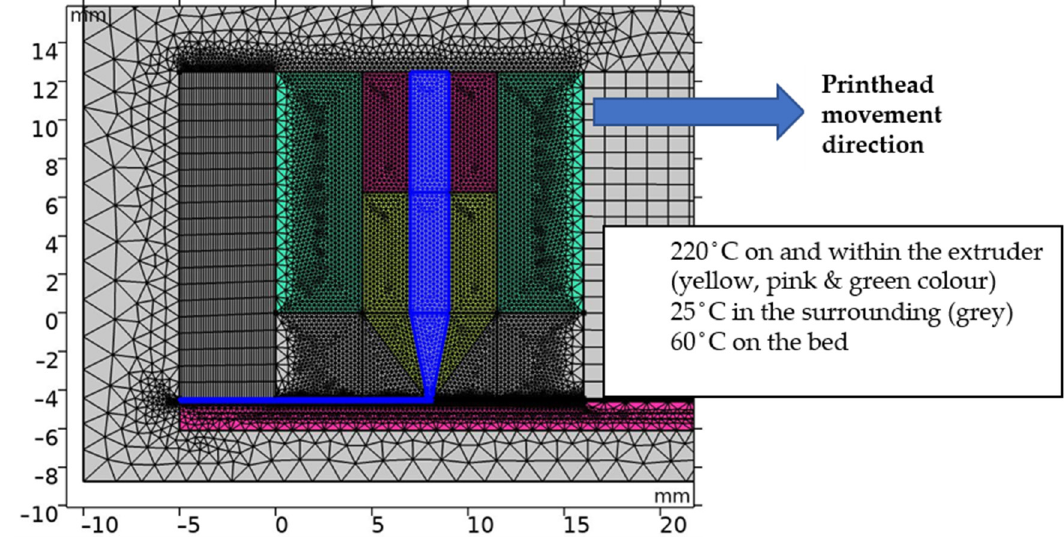
Figure 2. Geometry of the dynamic model with initial conditions; light turquoise—aluminum (heat block); blue—PLA (PLA material in the nozzle and on the bed); pink—steel (bed and heat break); yellow—brass (nozzle); gray—surroundings (air). The nozzle moves to the right.